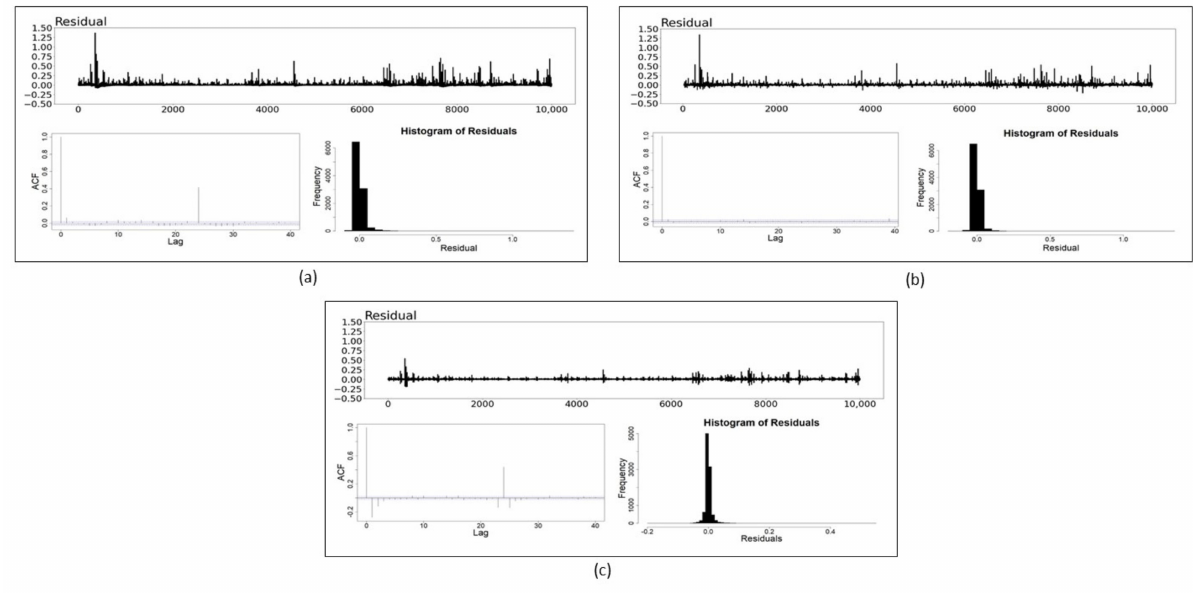
Figure 8. Residual plots, ACF plots and histograms of the: ( a ) GARCH (1,1) model; ( b ) NN model and ( c ) SS model for Bitcoin Cash. The blue dotted lines in ACF plots indicate the point of statistical